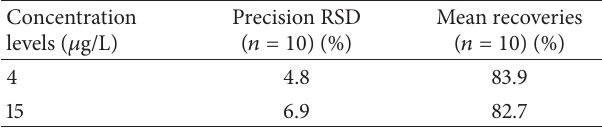
Table 2: Method precision and accuracy expressed as relative standard deviation and mean recovery, respectively; determined using 10 individual samples in each case.